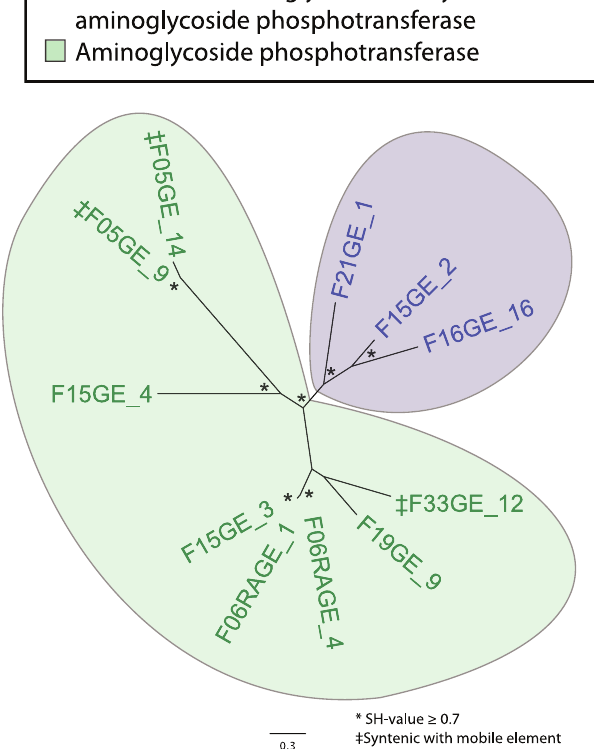
Figure 3. Unrooted approximate maximum-likelihood phylo- genetic tree constructed using the predicted amino acid sequences of all aminoglycoside aminotransferases and phos- photransferases in the study set. Enzyme classes are color-coded as indicated in the legend. At the terminus of each branch, the name of the source contig is listed. Aminoglycoside phosphotransferases that were syntenic with aminoglycoside acetyltransferases are indicated with purple bold text and marked with a ` . Genes syntenic with a mobile element are bolded and marked with a 1 . Nodes with a Shimodaira-Hasegawa (SH)-value . =0.7 are starred.